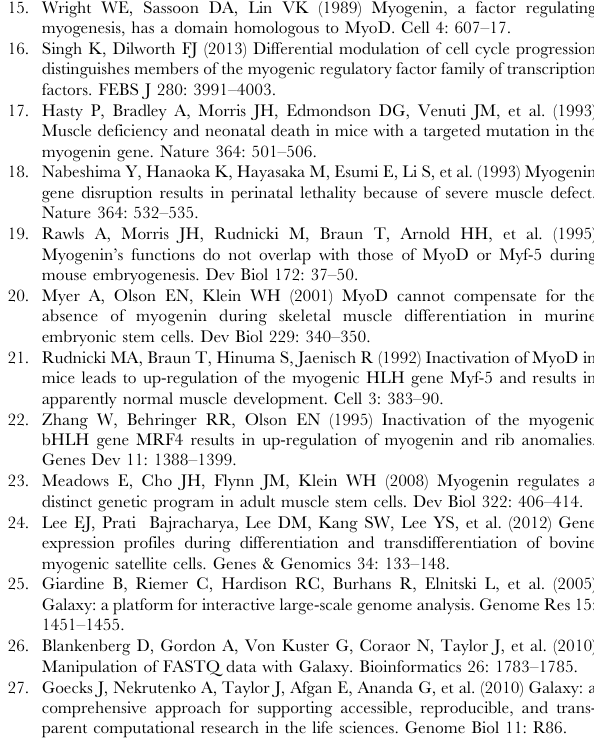
Figure 5. KEGG pathway map analysis of differentially expressed genes ( $ 4-fold change). Among the various different pathways reported by KEGG analysis, two representative pathways A ) PI3K-AKT and B ) MAPK are shown. For each rectangular shape, red and green borders indicate up-regulated and down-regulated genes, while the yellow star indicates a role of phosphoprotein. Each KEGG pathway analysis figure depicts the role or involvement of a specific gene or a family of related genes at a particular location in the pathway. For instance, the FGF gene in KEGG MAPK pathway map represents the other FGF members (such as FGF10, FGF11, FGF12, etc) as well that may or may not be affected. Here, FGF represents all the members of fibroblast growth factor family. For FGF family members, the gene that exhibited . 4 fold increase includes FGF11 whereas FGF10, FGF16, and FGF18 showed . 1 fold increase in their expression rates. Conversely, the other FGF members that showed , 4 fold decreased expression include FGF12 and FGF14. Similarly, FGFR represents the other members (FGFR1, FGFR2, etc) of this family of receptors as well. In case of FGFR family, FGFR2 showed . 4 fold decrease in its expression, and FGFR4 exhibited . 1 fold decrease in its expression rate. However, FGFR1 and FGFR3 showed about 1 fold increase in their